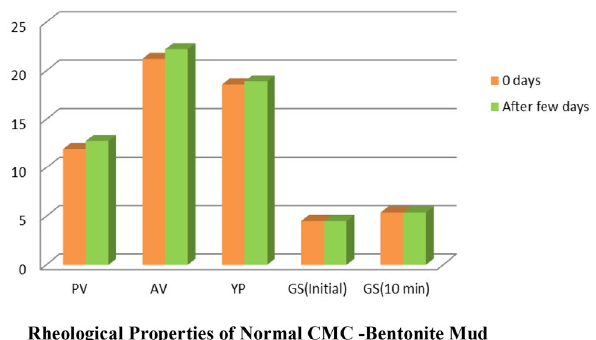
Fig. 33 Swelling/spalling of non-optimized vs optimized CMC–ben- tonite and PHPA–bentonite